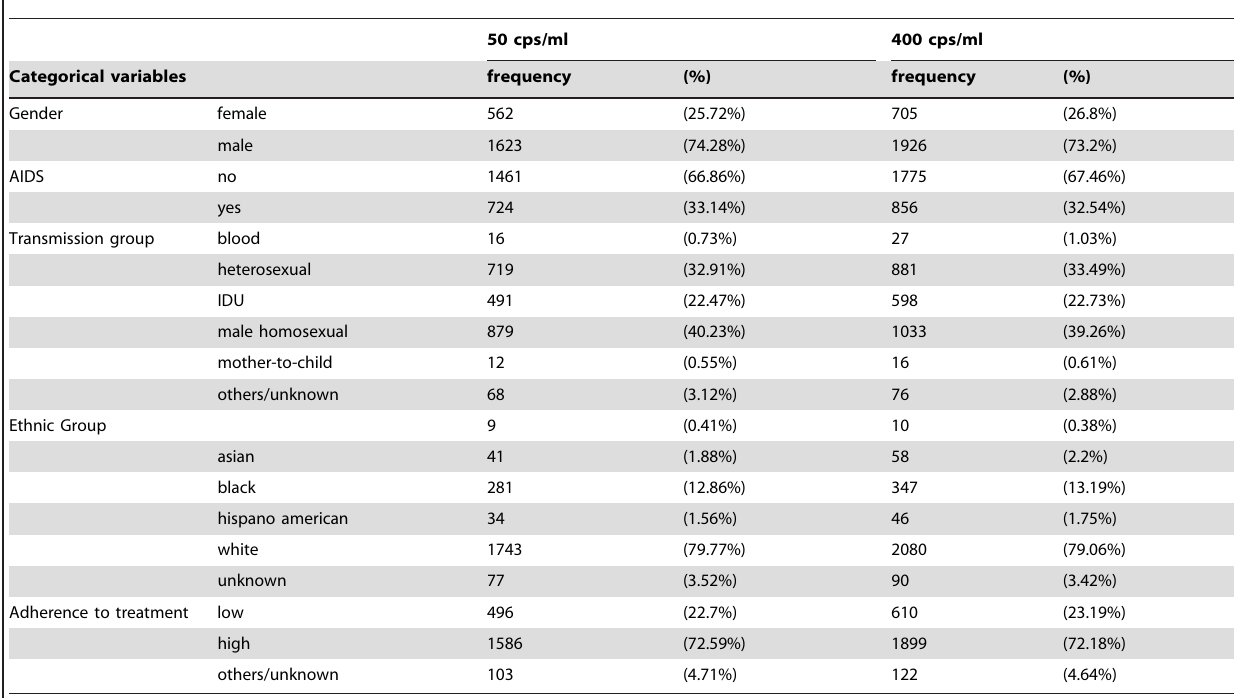
Table 2. Characteristics of the categorical predictors in the SHCS